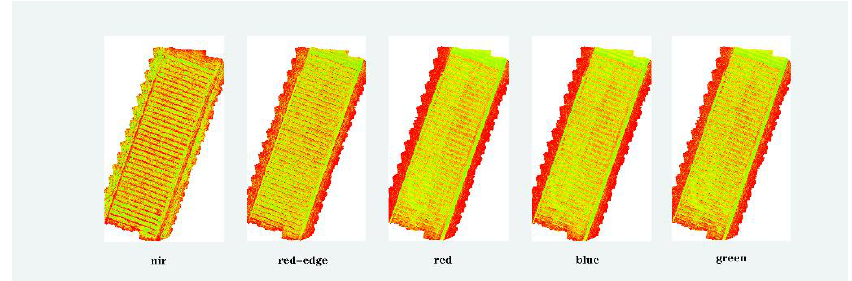
Figure 1. UAV image capture and single-band image extraction at the test site.